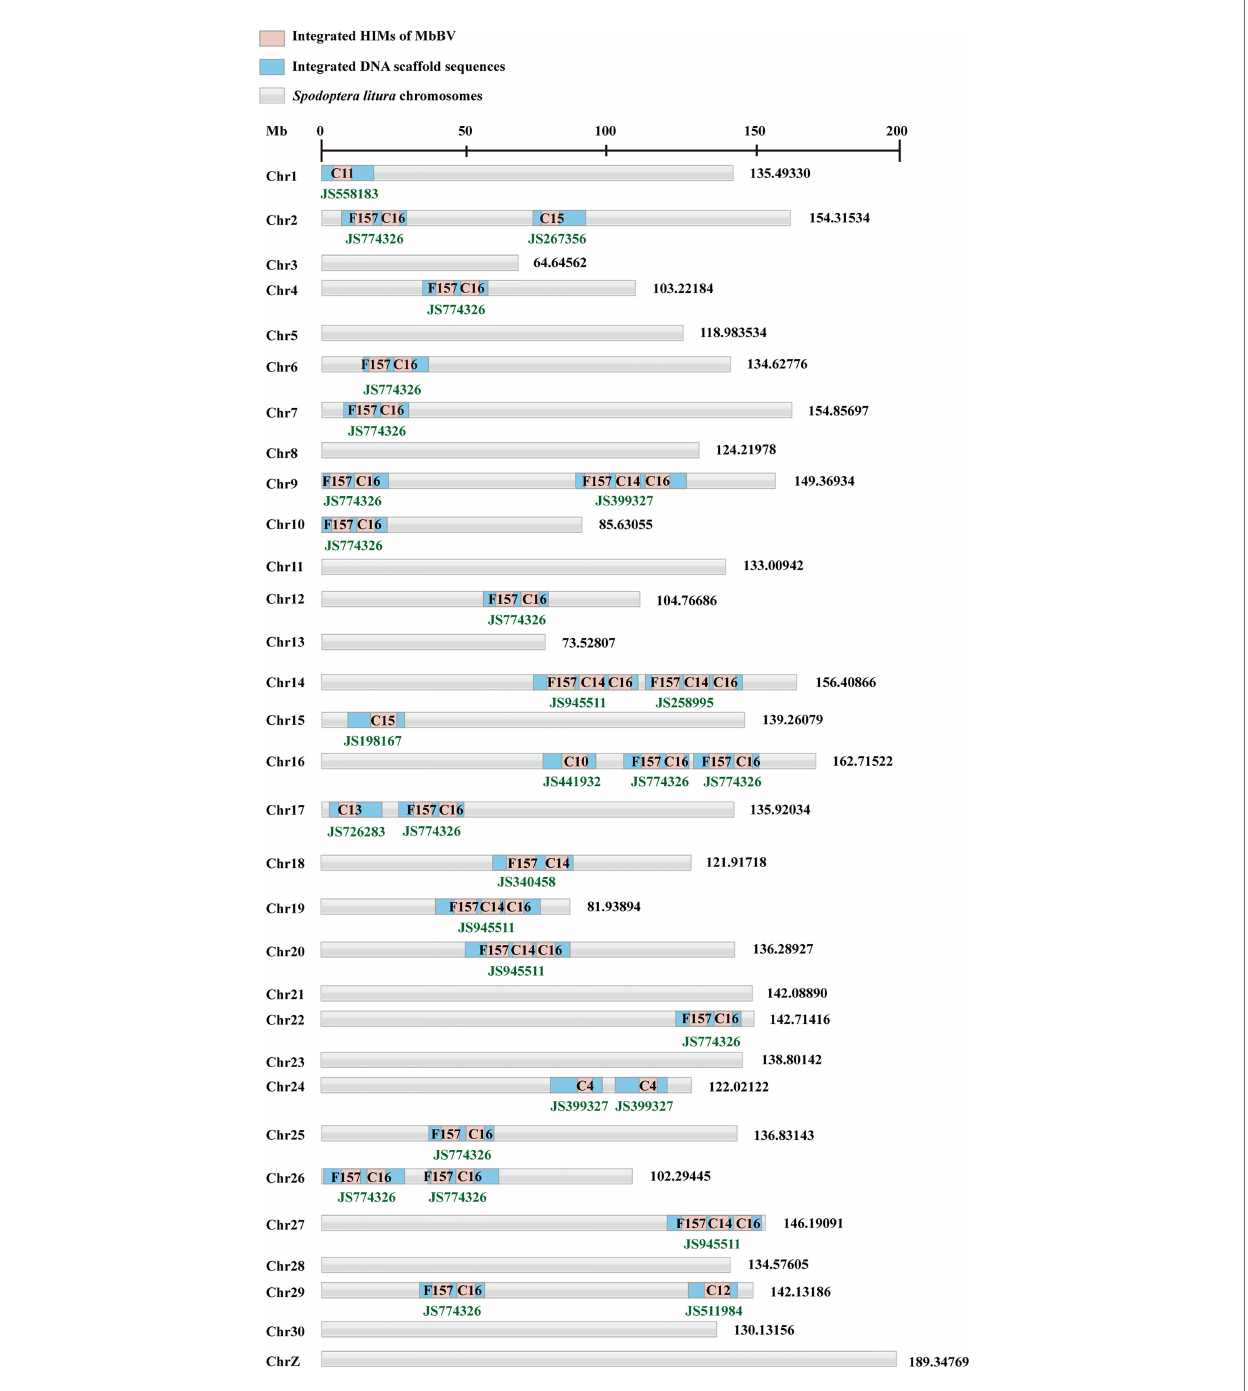
FIGURE 2 | Bracovirus primarily integrates host Spodoptera litura genome via host integrated motif. See also Figure S2 , Tables S1 and S2